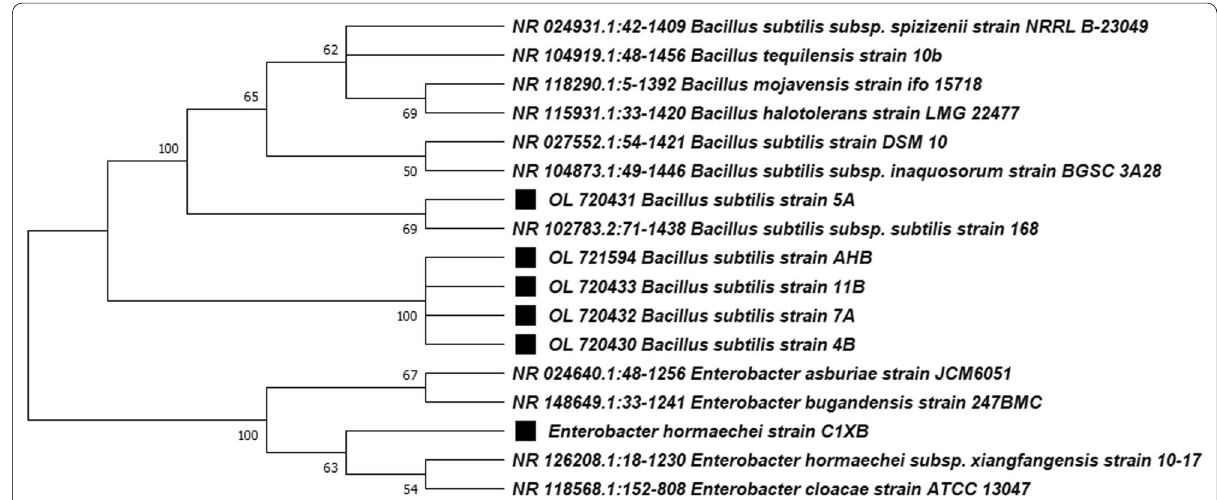
Fig. 1 The evolutionary analysis of the best biologically active bacterial isolates as analyzed by phylogenetic tree constructed by the maximum likelihood method using MEGAX software for the 16S rDNA sequences of Bacillus subtilis strains 7A, 5A, 4B, AHB and 11B as well as Enterobacter hormaechei strain CIXB. The numbers at nodes represent the percentage values given by 1000 bootstrap samples analysis